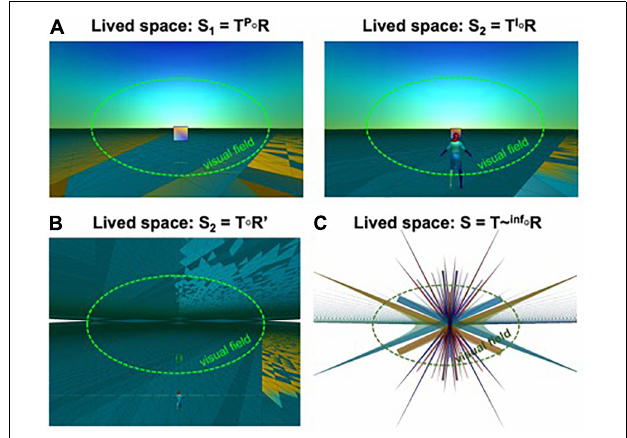
FIGURE 1 | Account of psychological phenomena. (A) Projective solution to VR-mediated dissociations in phenomenal selfhood. The visual field is indicated (dashed-green line) as a subset of lived space. Left : Projection from the normal perception spectrum: S 1 = T P ◦ R , the projective frame is calibrated in first-person perception-mode. Right : Third-person projection from the pure imagination subgroup: S 2 = T I ◦ R . Perceptual experiences of dissociation between the subjective point of view and the sense of location of the body induced by VR experiments using sensory conflict are explained by the PCM as the result of a projective solution that is not normally used for perception but is chosen as the best explanation of sensory data. (B) The anti-space beyond the plane at infinity. Rendering of the projective space with a transparent plane at infinity and no clipping, revealing the involution of the space mirroring the back of the ambient space intrinsic to projective spaces. (C) The “God’s eye” vantage point on the projective space. Rendering on a 2-dimensional image-plane of the projective space and its mapping of the world model R from the “God’s eye” point of view at infinity. Almost all the space is visible but completely warped and the world model manifests as structures with complex symmetries (from Rudrauf et al., 2017, used by permission from Elsevier).